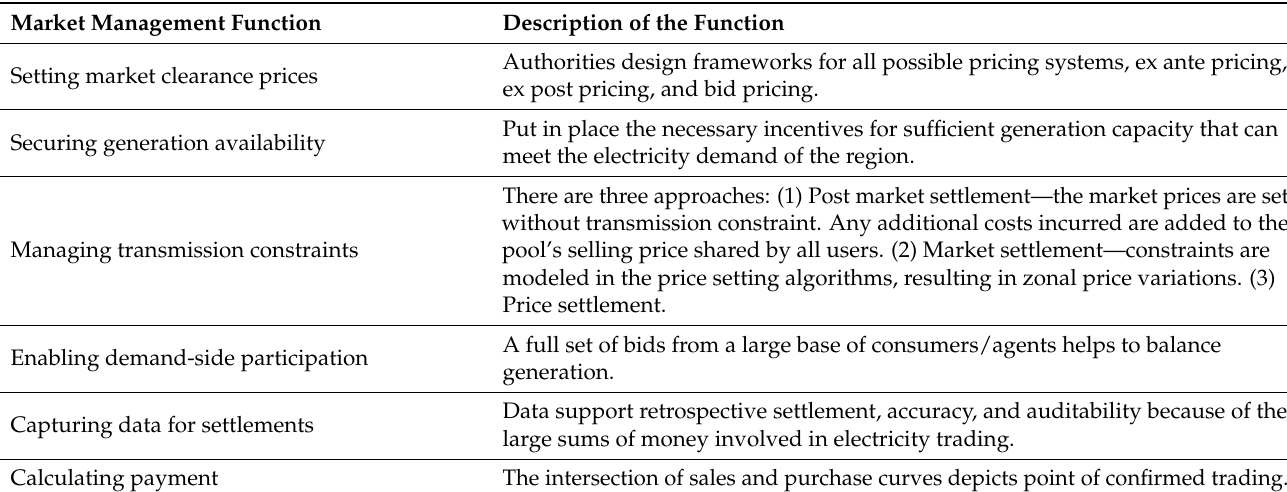
Table 5. Description of management function in EMI.